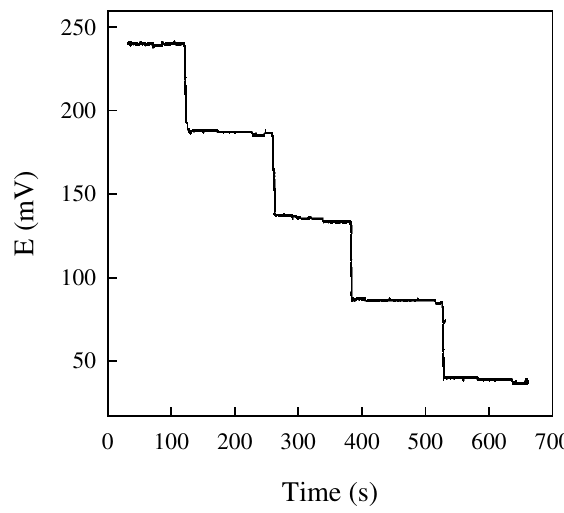
Figure 4. Typical potential-time recorder trace of the electrode based on Hg(MBT) Membrane compositions and measurement conditions are given in Table